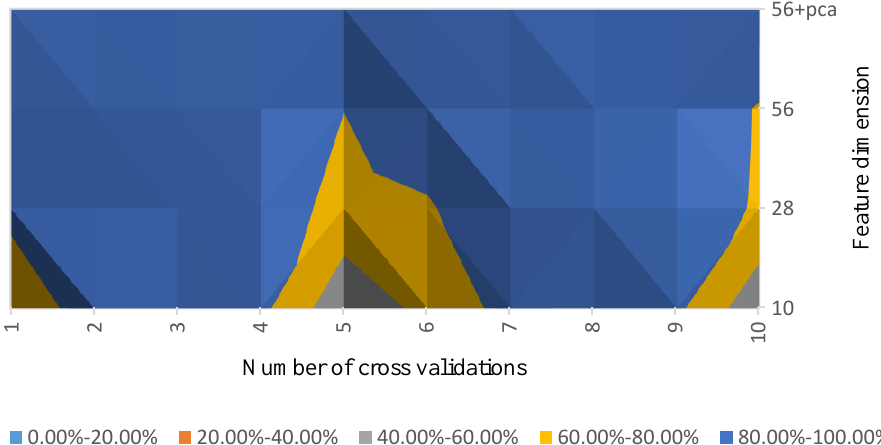
Figure 9. 10-fold cross-validation accuracy after feature construction.